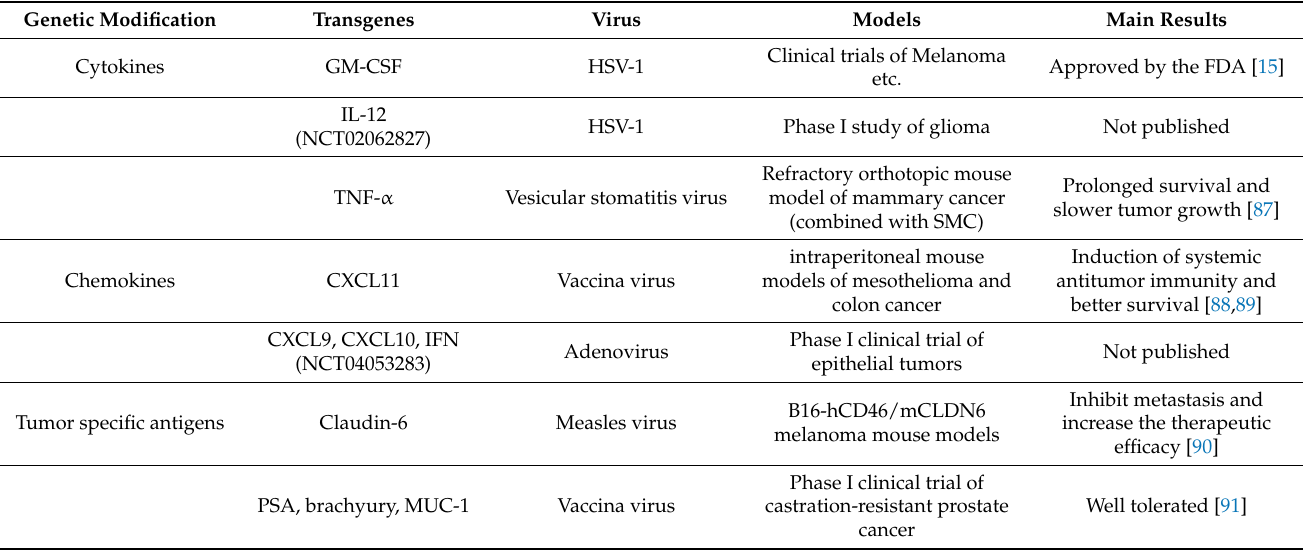
Figure 1. Strategies for improving oncolytic virotherapy. Strategies are divided into two main categories: improvements of genome engineering and of the delivery system. In terms of the genome engineering ( left ), various functional elements can be designed into the genome of oncolytic virus, including those can activate the immune system directly, specific recognition of cancer cells, tumor-suppressor genes, and inspirations from other therapies. In terms of the delivery system ( right ), multiple nanomaterials could be used as chemical modifications to the capsule of viruses. In addition, physical technology such as magnetic fields and ultrasound could also help in the guidance of oncolytic viruses. Stem cells, CAR-T cells, and even bacteria could be used as vehicles to transport oncolytic viruses. TAAs: Tumor-associated antigens; BiTE: Bispecific T cell engager; ICIs: Immune checkpoint inhibitors; VEGI: vascular endothelial cell growth inhibitor; PEG: poly(ethylene) glycol; CAR: chimeric antigen receptor; NK cells: natural killer cells. The figure is drawn by FigDraw. Table 2. Examples of genome engineering categories for oncolytic virus.